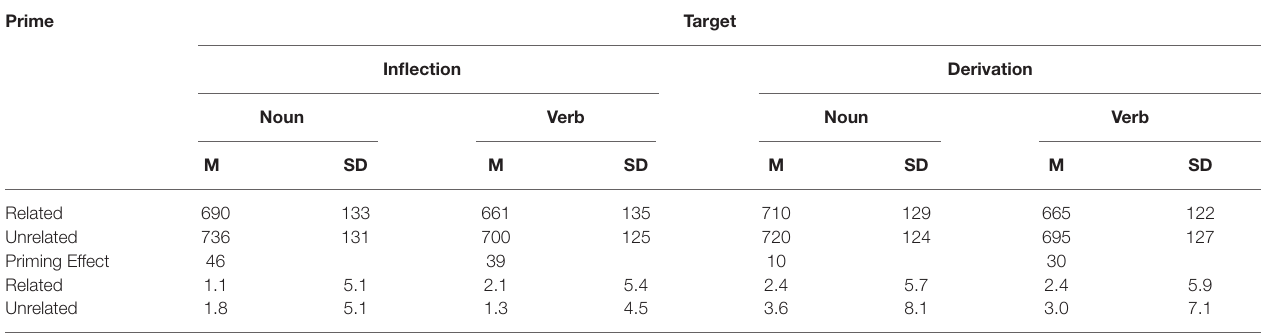
TABLE 5 | Response times and accuracy per condition in Experiment 1.